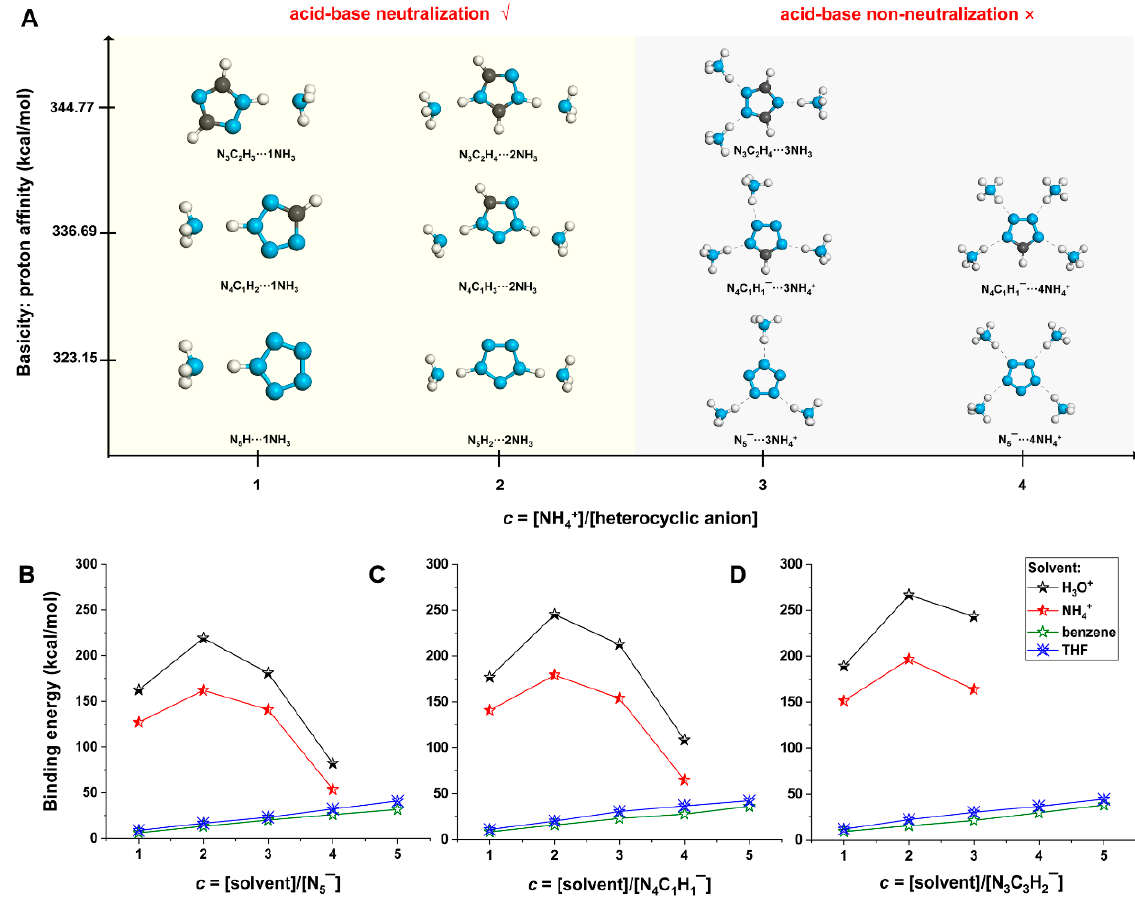
Figure 3. ( A ) Reactivity of N 3 C 2 H 2 ¯, N 4 C 1 H 1 ¯, and N 5 ¯ with increasing concentration of NH 4+ , and binding energy of ( B ) N 5 ¯ complexes, ( C ) N 4 C 1 H 1 ¯complexes, and ( D ) N 3 C 2 H 2 ¯complexes with increasing concentration of H 3 O + (black line), NH 4+ (red line), benzene (olive line), and THF (blue line).